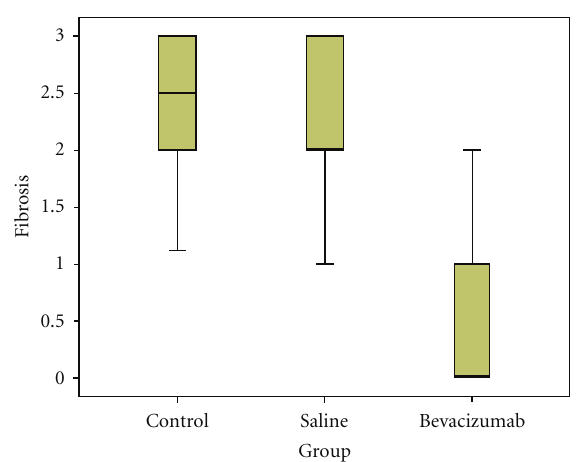
Figure 4: The bevacizumab group had a significantly lower fibrosis scores.